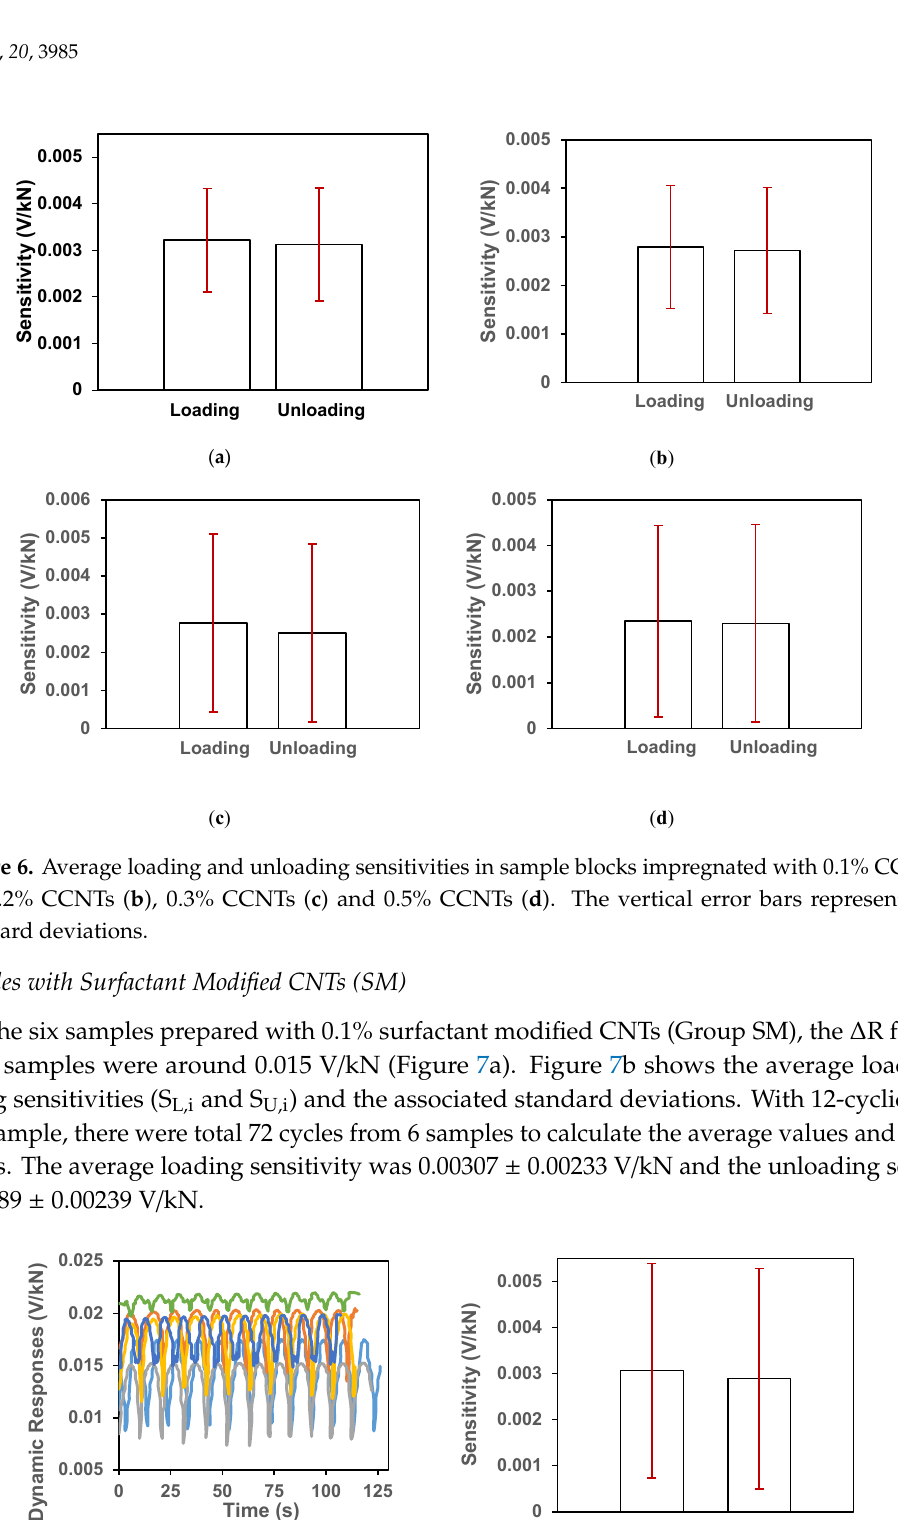
Figure 5. Dynamic load responses in sample blocks impregnated with 0.1% CCNTs ( a ), 0.2% CCNTs ( b ), 03% CCNTs ( c ) and 0.5% CCNTs ( d ). The multiple plots represent responses from each sample from Group B.